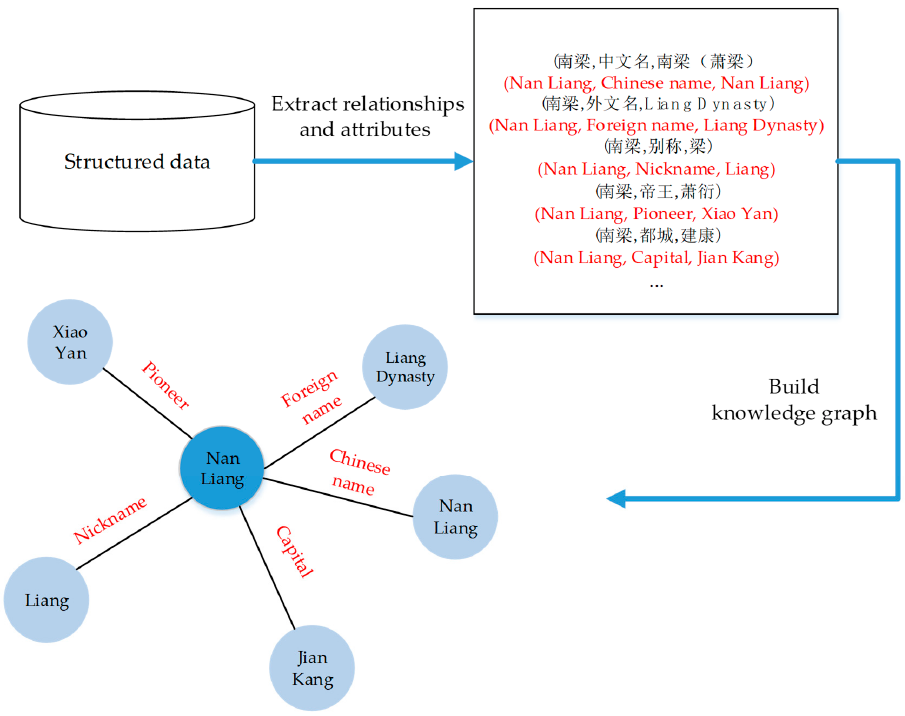
Figure 4. Structured data to graph database stored procedures.